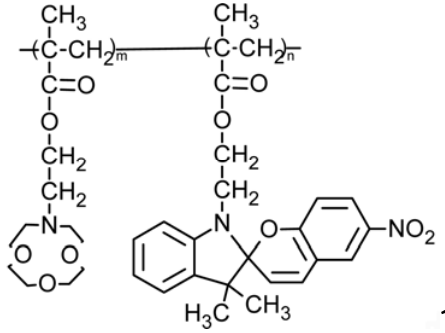
Figure 17. Chemical formula of crown ether–spirobenzopyrans copolymer of [121].